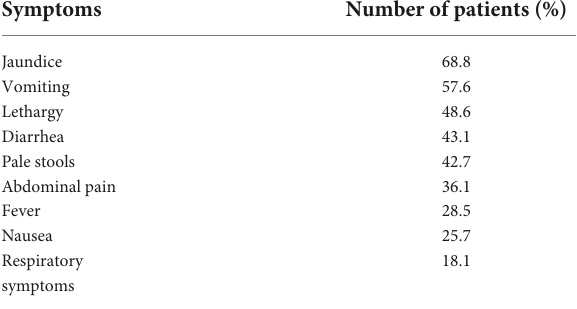
TABLE 2 The main symptoms in UK cases with acute hepatitis of unknown